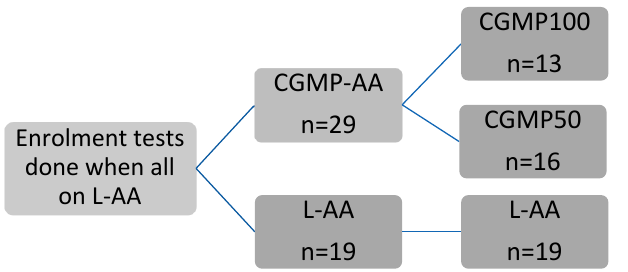
Figure 1. Diagram of the scheme for study methodology, from enrolment to 36 months. Legend: CGMP, casein glycomacropeptide; CGMP100, children taking all their protein substitute as casein glycomacropeptide; CGMP50, children taking a combination of casein glycomacropeptide and amino acids; L-AA, amino acids